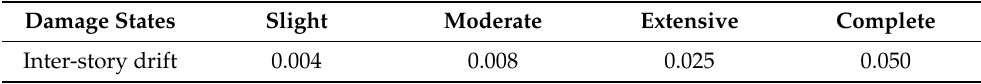
Table 8. Damage states for nonstructural drift-sensitive components. Table 9. Damage states for nonstructural acceleration-sensitive components. Damage States